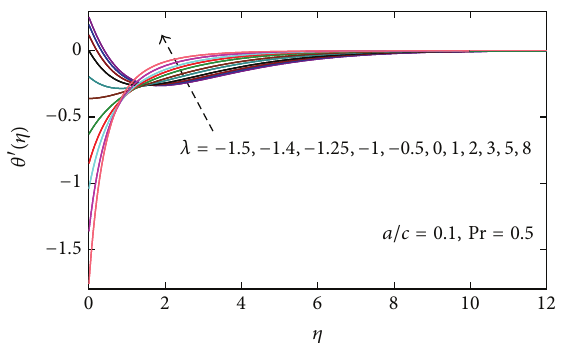
Figure 8: Temperature gradient profiles 𝜃 󸀠 (𝜂) for various values of 𝜆 with 𝑎/𝑐 = 0.1